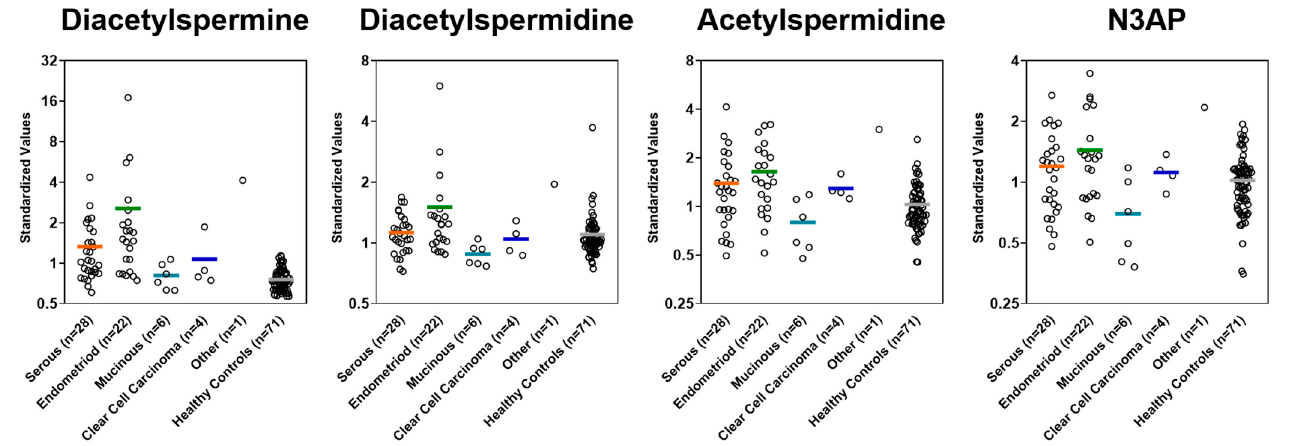
Figure A3. Plasma levels of polyamines in cases stratified by histology and controls in the Validation Set.